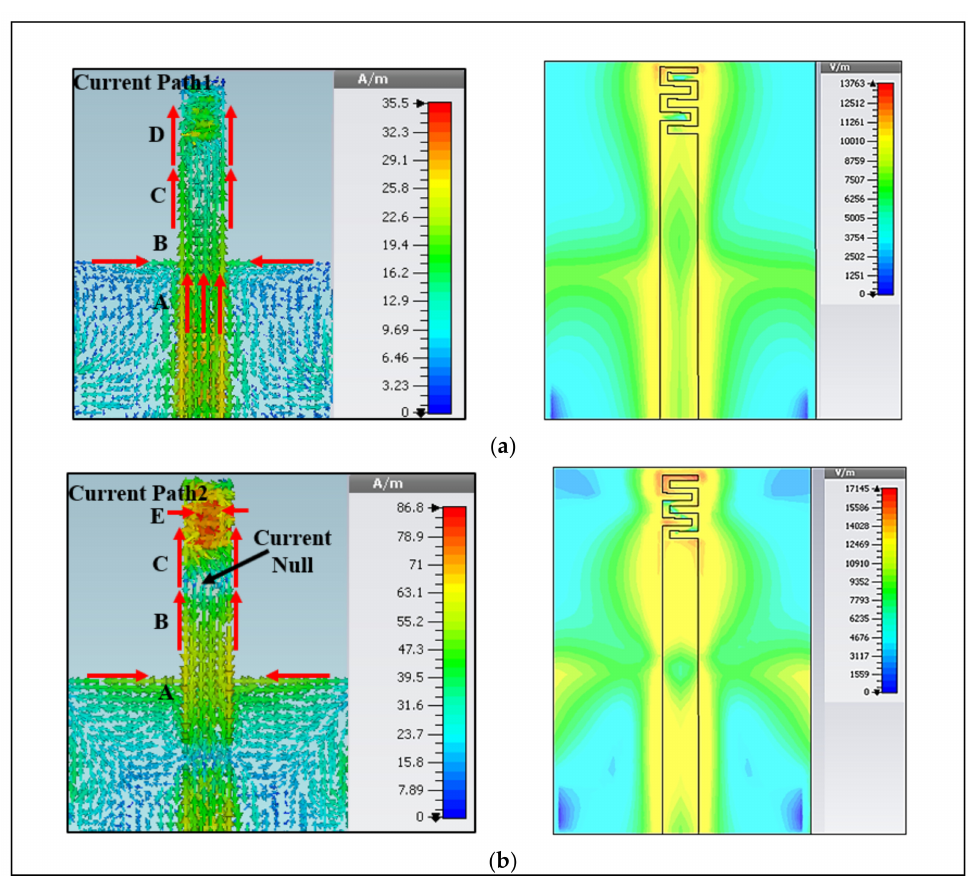
Figure 3. Distribution of current density with radiation modes at ( a ) lower band, and ( b ) upper band. The simulated reflection coefficients (S 11 ) of various antennas and their effects of length on the overall reflection coefficient are shown in Figure 4. The length of the top monopole-shaped meander line strip and a truncated ground plane has a great impact on the resonant frequency and impedance bandwidth (BW). Increasing or decreasing the length of the monopole strip ( l 1 ) results in a lower resonant frequency. The length of ( l 1 ) and a ground plane has a great impact on the operating frequency and impedance BW in the lower band, varying the length from 40.20 mm to 36.49 mm shifted the resonant frequency from approximately 2.8 GHz to 3.4 GHz, while there was a minor effect on the upper impedance bandwidth (BW), which shifted from 5.90 to 6.295 GHz. The length of the meander line strip ( l 2 ) also affects the resonant frequency and impedance bandwidth (BW) in the upper band. Varying the length from 8.49 mm to 4.49 mm drastically shifted the resonant frequency from approximately 5.7 GHz to 9.0 GHz, pushing it out of the required band for Wi-Fi/WLAN, with a huge effect on the lower band. Moreover, we have examined the antenna structure, in which the monopole strip current is concentrated on the meander line, which further reduces the impact from the bending and provided stability in the design. Therefore, in our proposed antenna, we observed that the S 11 changes with length, as well as how it shifted the frequency and optimized the dimensions to minimize this shift. The optimized design parameters are listed as above in Table